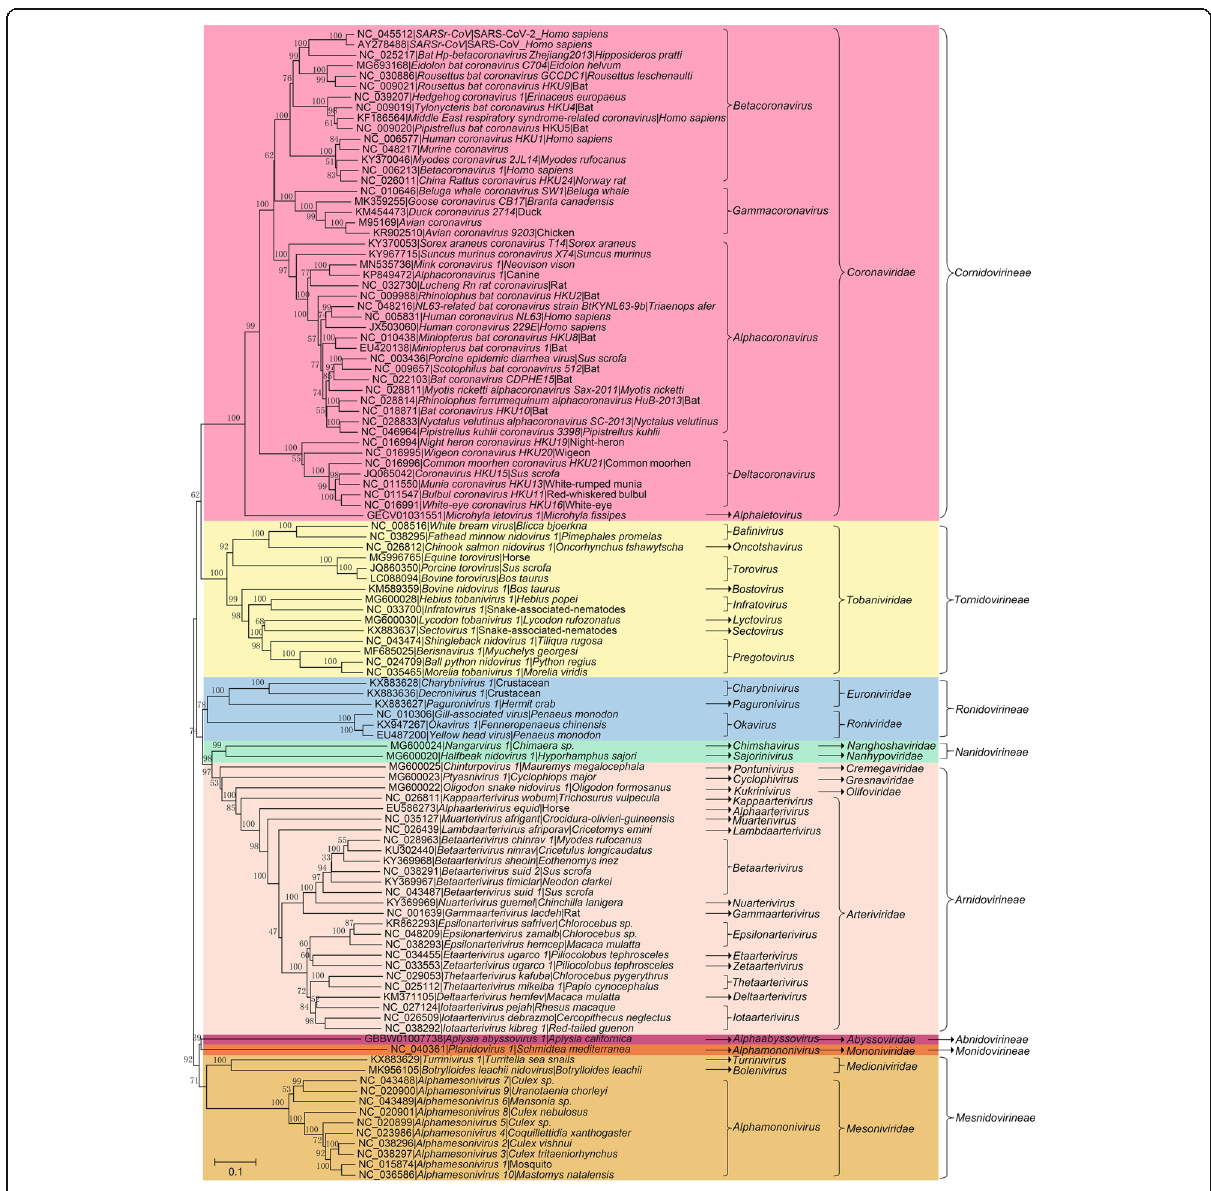
Fig. 1 Phylogenetic tree of RNA-dependent RNA polymerase (RdRp) amino acid sequences of 109 viral species in the Nidovirales order. The tree was constructed using the neighbor-joining method with a p-distance model and 1000 bootstraps in the MEGA V.